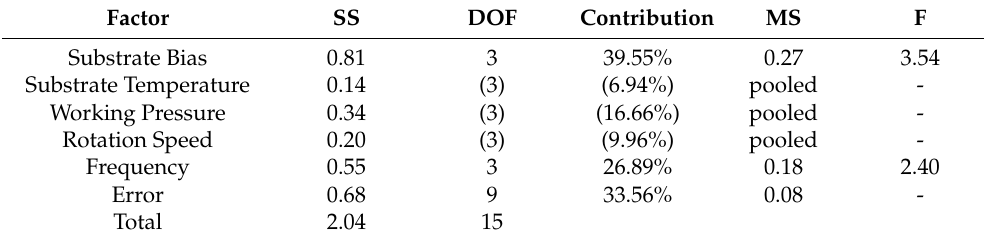
Table 4. ANOVA analysis results for film resistivity. () indicates non-dominant